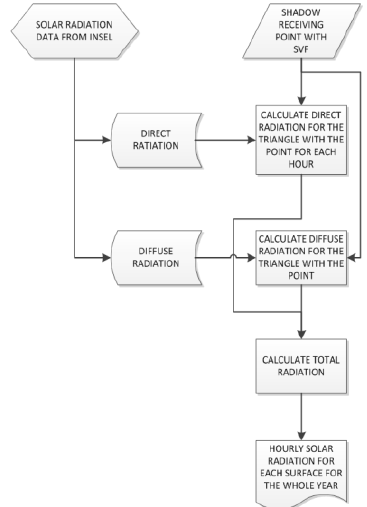
Figure 5: Workflow of solar radiation calculation for each surface for a year